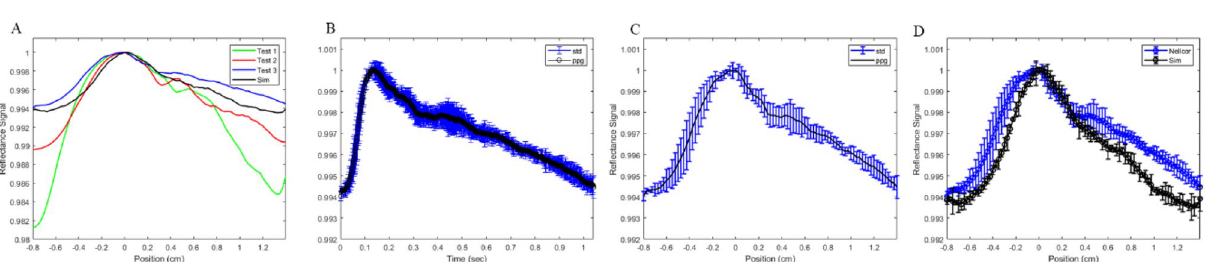
Figure 5. PPG data of radial artery taken at the volar location of the wrist of three different preliminary tests, each test is from a different individual. Note x-axis label is in time whereas simulation data pulse is developed through pulse position. ( B ) Experimental data of Test 3. ( C ) PPG adjusted for from time to pulse position. ( D ) Overlay of experimental PPG and simulated